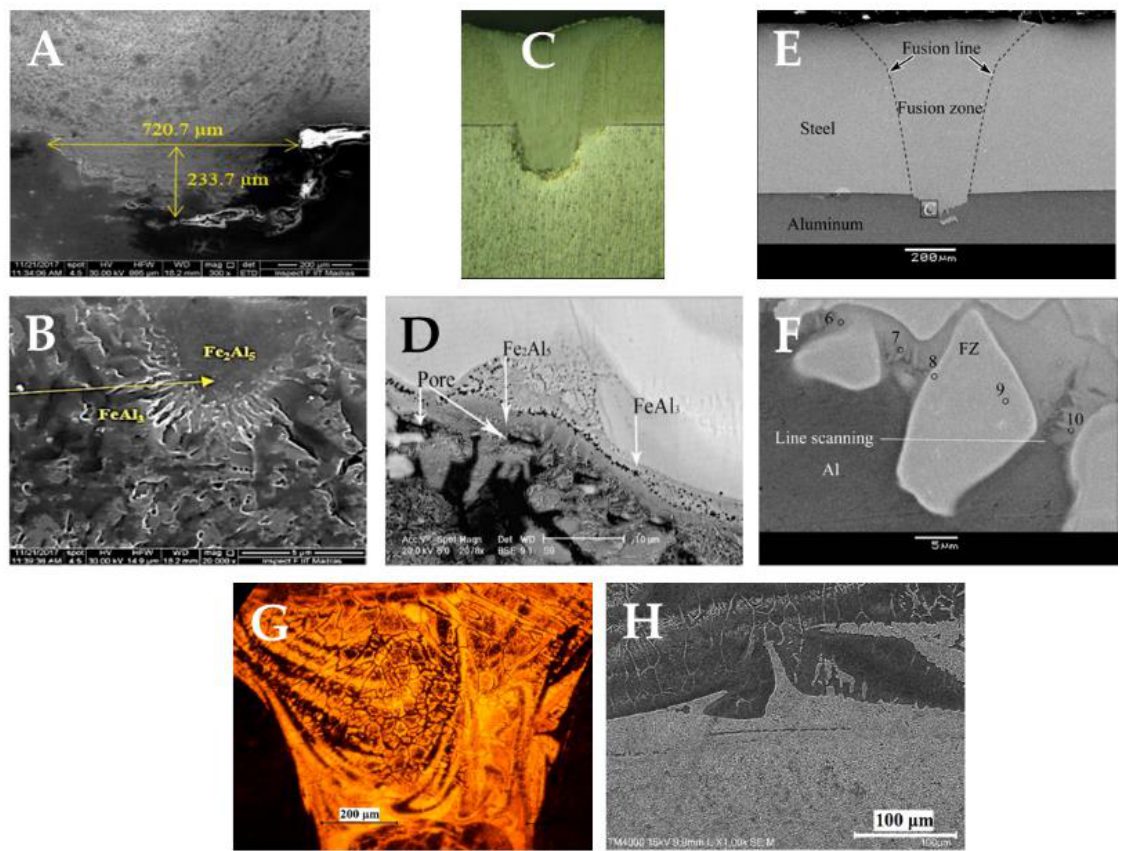
Figure 15. Pulsed laser weldments made of dissimilar aluminium alloys: DP 600 steel and AA6061 ( A ) and its FZ ( B ) [20], AA5754 and St14 steel ( C ) and its weld interface ( D ) [101], 316L and AA1060 ( E ) and its weld interface ( F ) [87], and AA1050 and DP1000 steel ( G ) and its weld interface ( H ) [103]. Table 7. Selected results of pulsed laser welding apply to dissimilar aluminium alloys (approximated